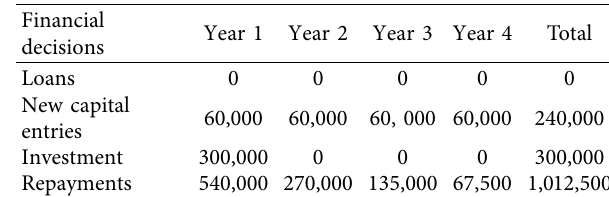
Table 7: Financial decisions for each year for the developed model with new financial aspects.